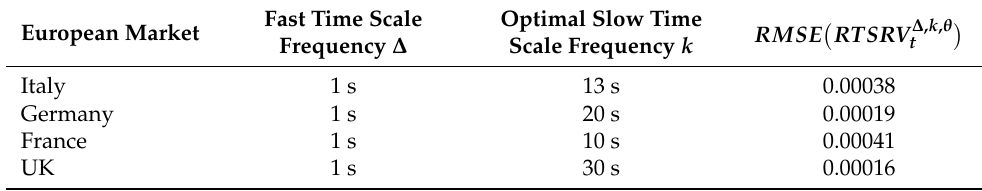
Table 3. Selection of sampling frequencies on both scales for every market individually.